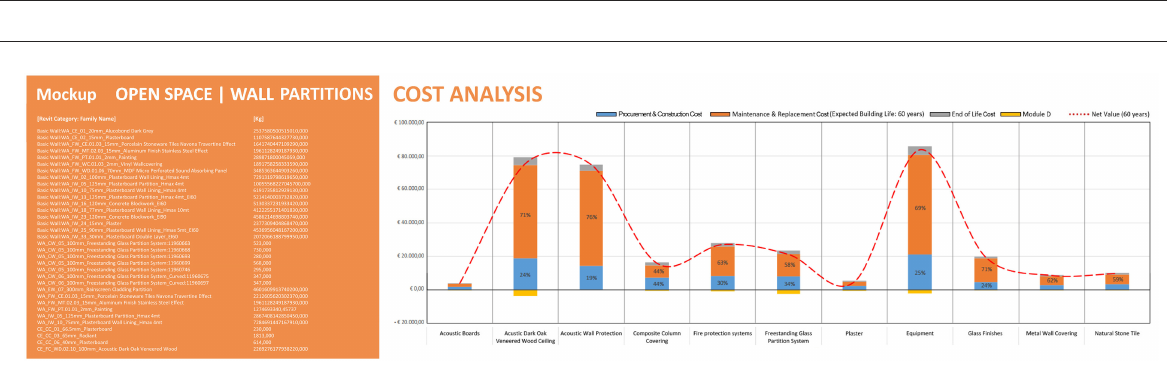
FIGURE7 Cost analysis of the interior wall partitions and finishes, categorized by building life stages: Procurement and construction, maintenance and replacement, and end of